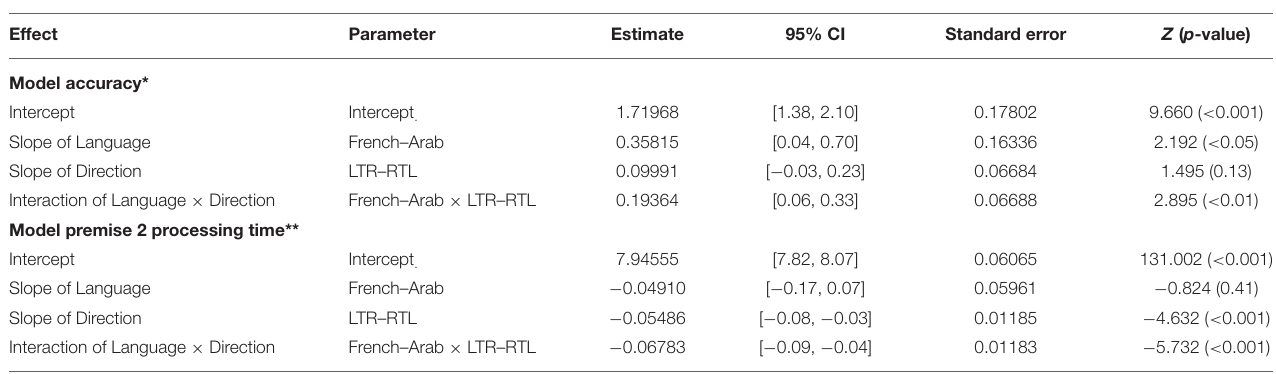
TABLE 6 | Parameters estimates of models Accuracy and Premise 2 processing